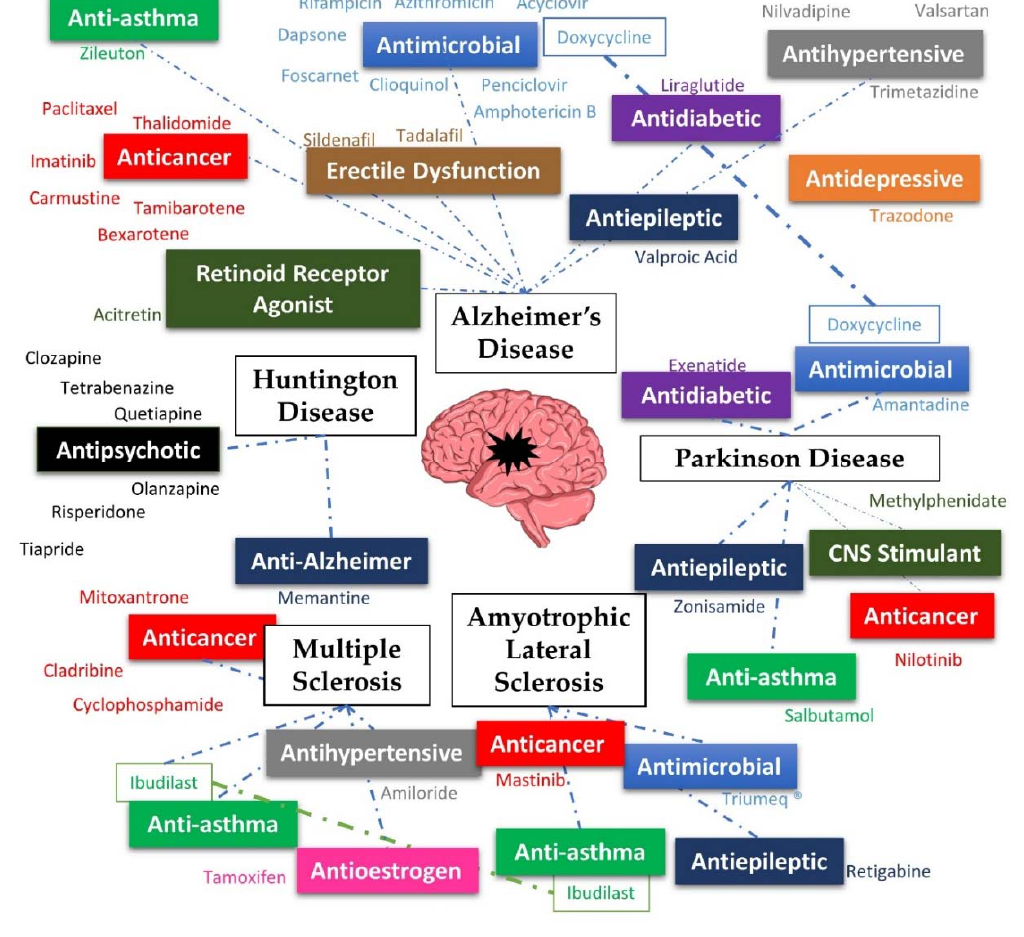
Figure 1. Summary of the diseases and repurposed drugs presented in this review.